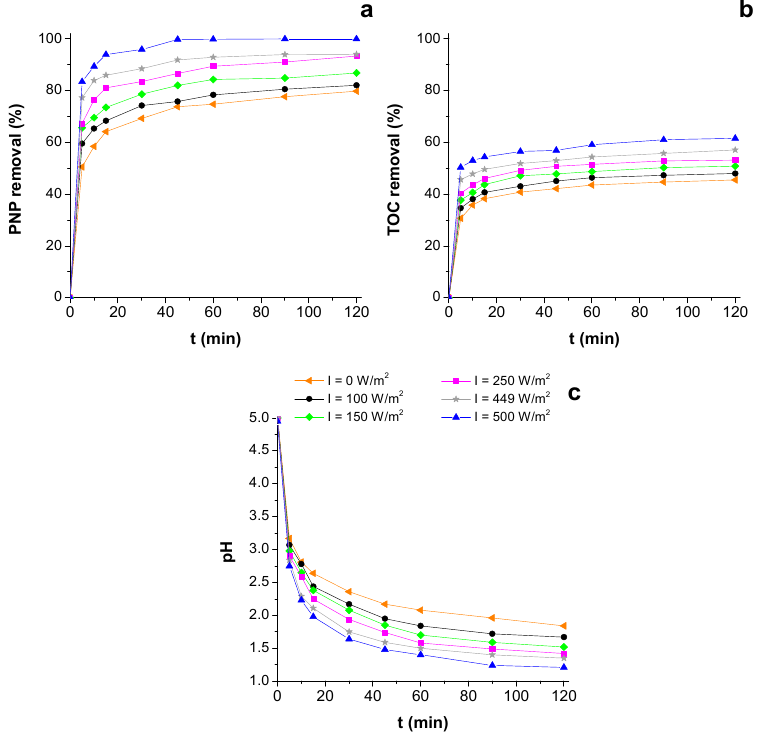
Figure 4. PNP ( a ) and TOC ( b ) removals and pH evolution ( c ) for different radiation intensities during the persulphate oxidation process ([PNP] o = 500 mg/L, pH = 5.0, T= 70 °C and [S 2 O 82 − ] o, = 6.4 g/L).